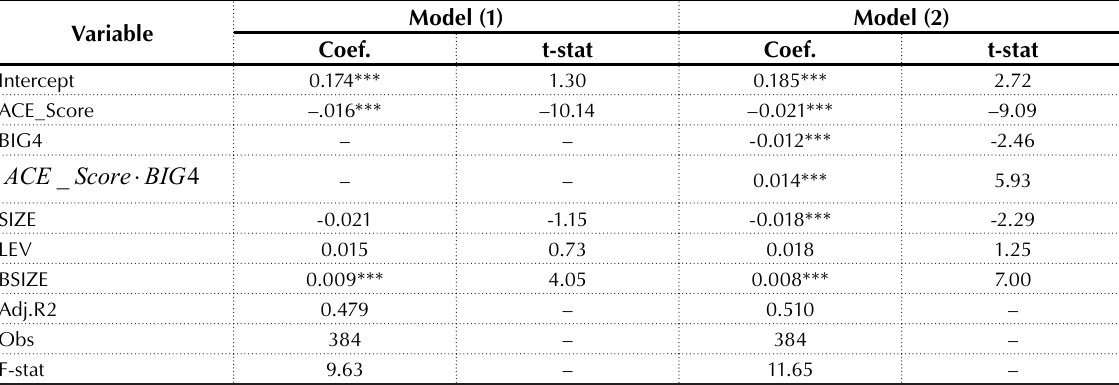
Table 2. Regression analysis of earning management, audit committee effectiveness and Big 4 audit